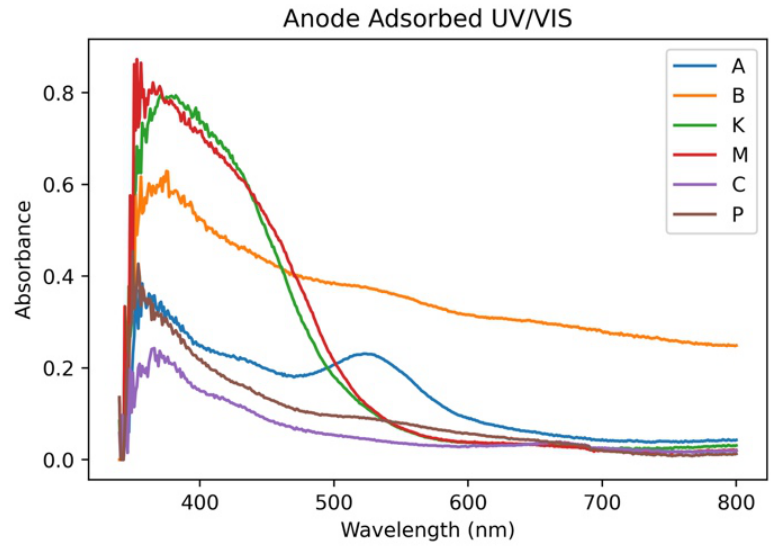
Figure 5. UV-Vis spectra of the six constituent dyes (10 μM concentration).